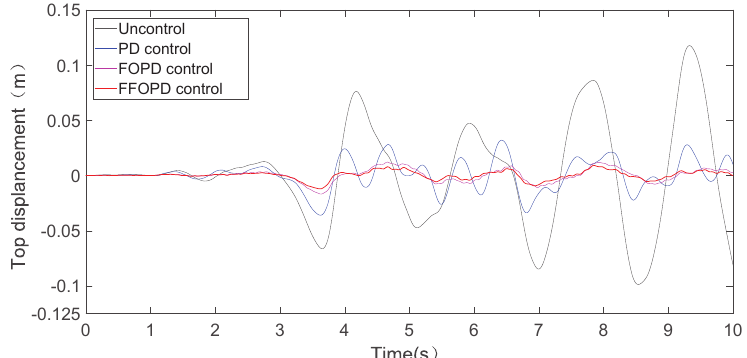
Figure 13. Top floor displacement curve under El-Centro earthquake.